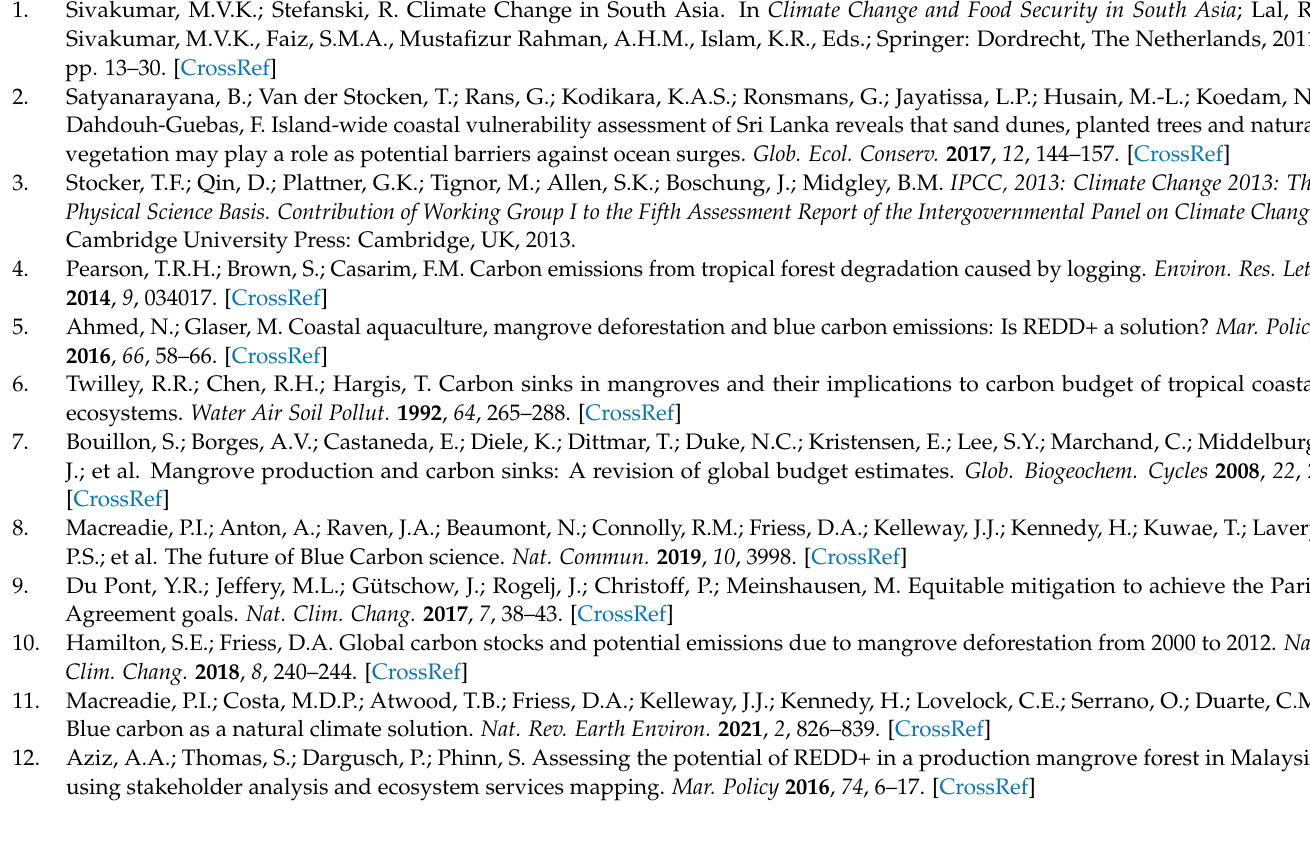
charcoal exportation.; Table S9: Distance (km) from the Companies to the Port terminals in Malaysia for charcoal exportation; Table S10: Distance (km) from the charcoal factories to the registered workers’ residence; Table S11: Estimates of exhaust emission factors for cargo ships (g/ tonne-km); Table S12: Distance from Malaysia port terminals (Port Klang and Penang) to Japanese terminals for charcoal exportation; Table S13: Car Standard Emissions (g/km); Table S14: Moped Standard Emissions (gC.km − 1 ); Table S15: Distance in km from the charcoal factory to the places where pole are sold; Table S16: Emission factors for light and heavy truck transport (gC.km − 1 ) used for pole transport. The references in SM can refer to